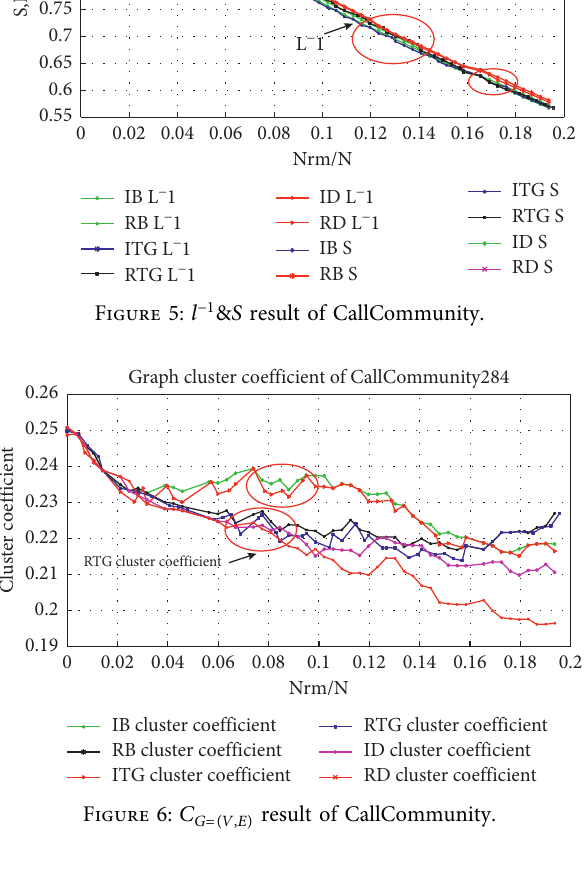
(2) During the fall process of l − 1 , the RTG curve, RB curve, and RD curve look like falling faster than other three removal strategies.